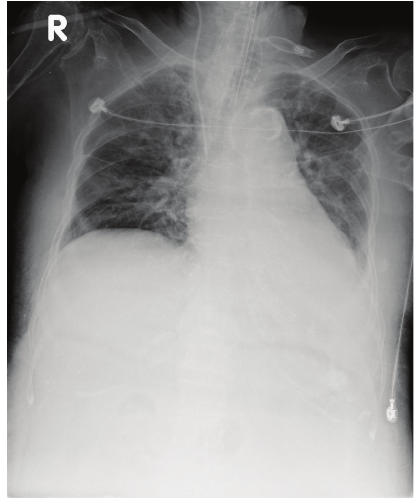
Figure 3: Day 3 on steroid